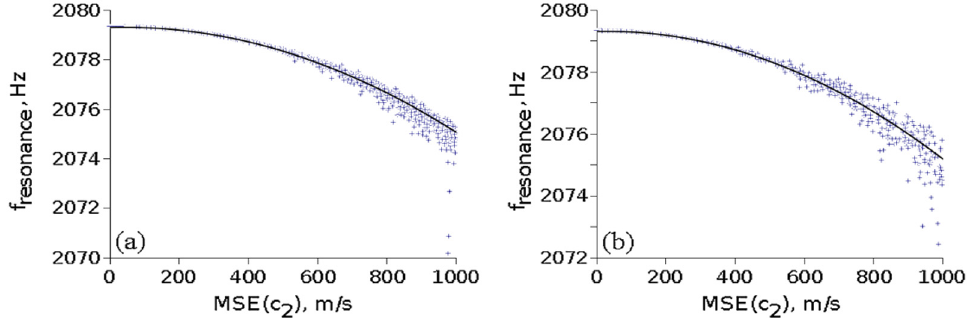
Figure 5. The influence of medium inhomogeneity on its first eigenfrequency for c 2 with ( a ) random values; ( b ) random walk values .